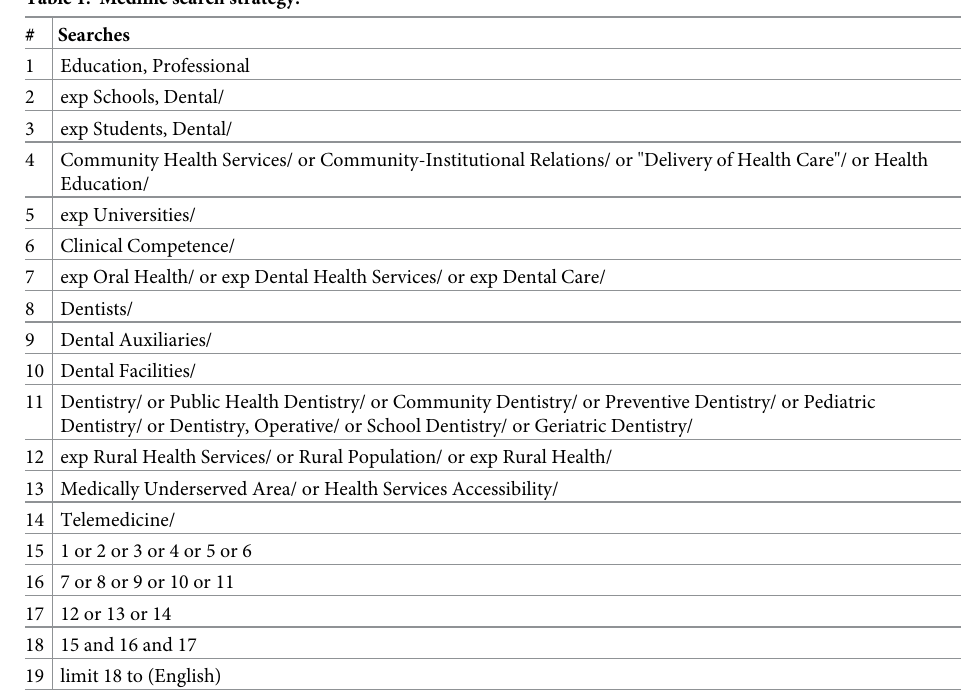
Table 1. Medline search